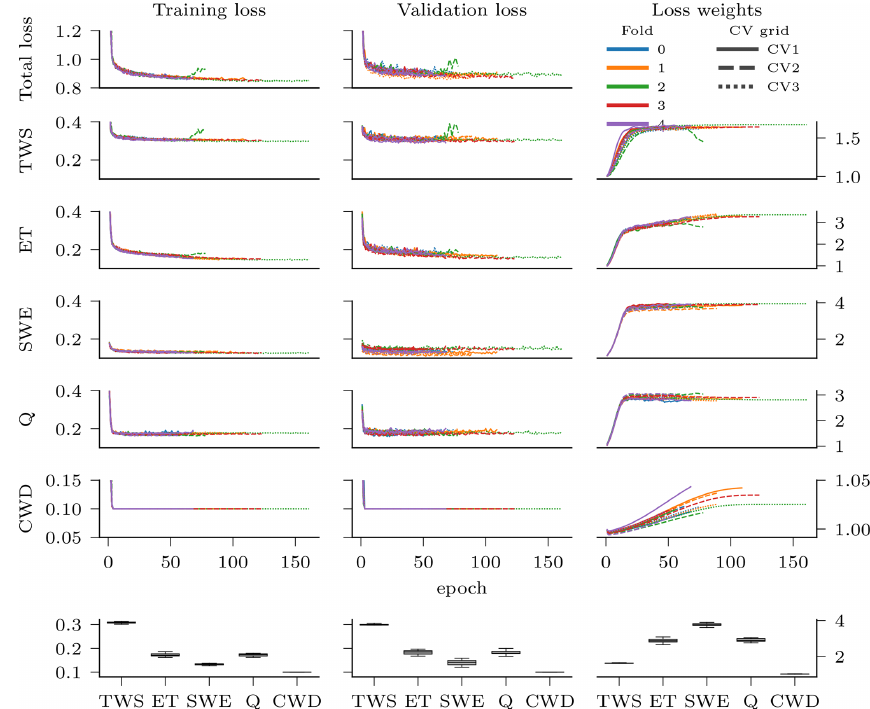
Figure C1. Model training process for the cross-validation runs. The left and central columns represent the unweighted total and variable- specific mean squared error (MSE) loss. The right column shows how the task weights developed over training time. The x axis represents the number of iterations through the training set (epochs). The bottom row contains the column-wise distribution of the variables losses (or weights) at the end of the model optimization. Note that, for the soft constraint on CWD, a bias of 0.1 was added, i.e., 0.1 is the optimum.